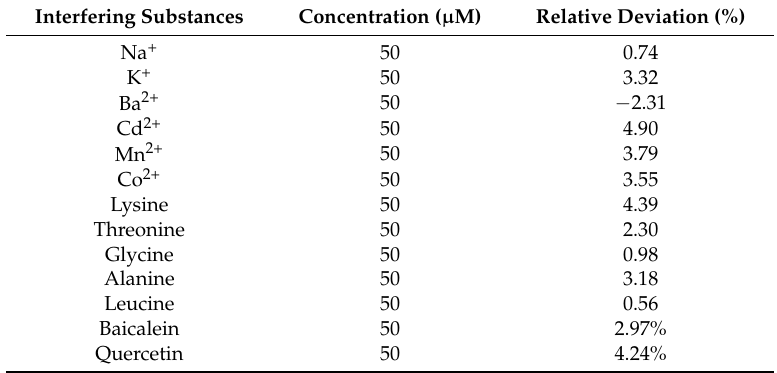
Table 2. Summary of the detection of 1 µ M luteolin in the presence of 50 µ M interfering substances. Interfering Substances